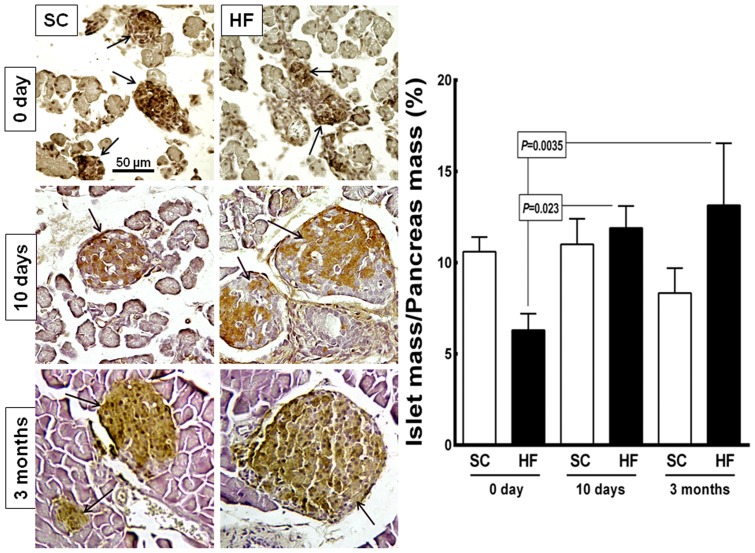
Offspring pancreas.
Left side: microscopic images of the pancreas tissue immunostained with an anti-insulin antibody (beta cells, same magnification in all pictures). In the pancreata of mice at birth, we observed small dense islets (arrows) embedded in loose tissue in the both SC and HF groups. On postnatal day 10 and further at 3 months of age, the islets are more organized than at birth. The islets are larger in the HF offspring than in the SC offspring. Right side: bar graph of the islet mass/pancreas mass ratio (mean and standard error of the mean). Significant differences are indicated (one-way ANOVA and post-hoc Holm-Sydak test). Abbreviations: SC, standard chow group; HF, high fat diet group.